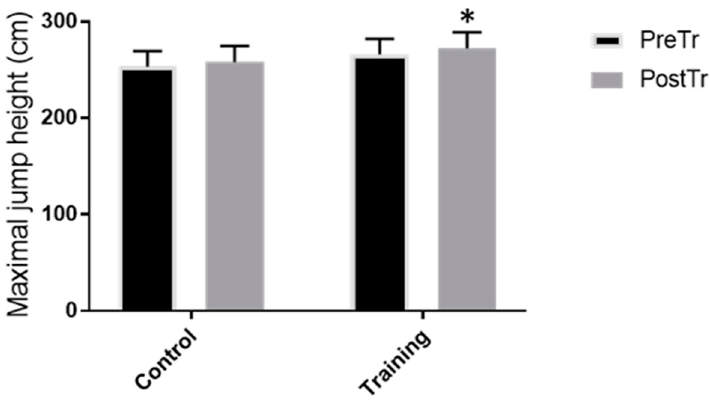
Figure 5. Functional test measures: jump height (cm) before and after 8 weeks of plyometric jump training or rest. Peak values represent the highest of the three test jumps. * p < 0.001.